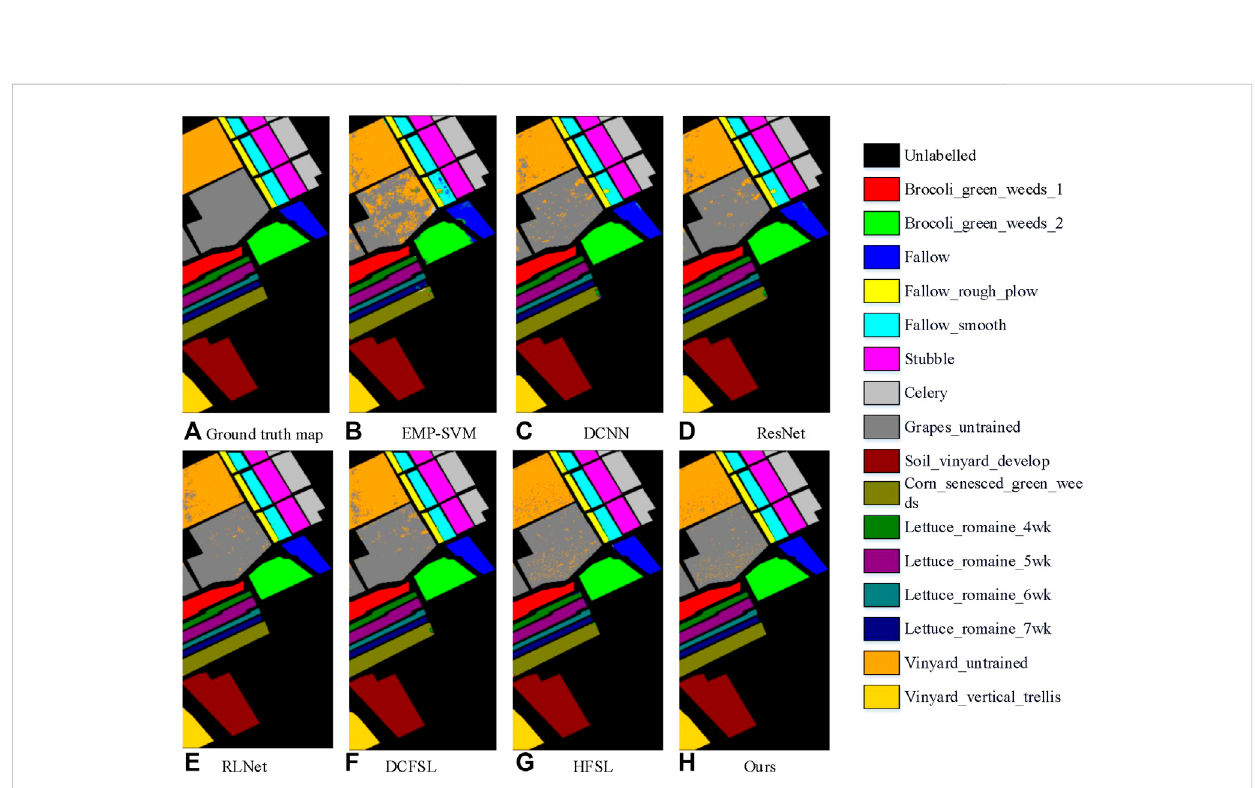
FIGURE 3 Classi fi cation maps of the Salinas dataset. (A) ground truth; (B) EMP-SVM; (C) DCNN; (D) ResNet; (E) RLNet; (F) DCFSL; (G) HFSL; (H)